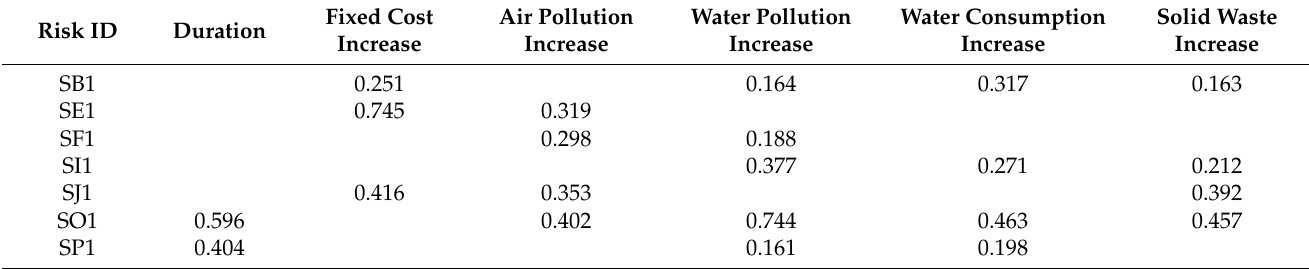
Table 10. Summary results of sustainability-related risk